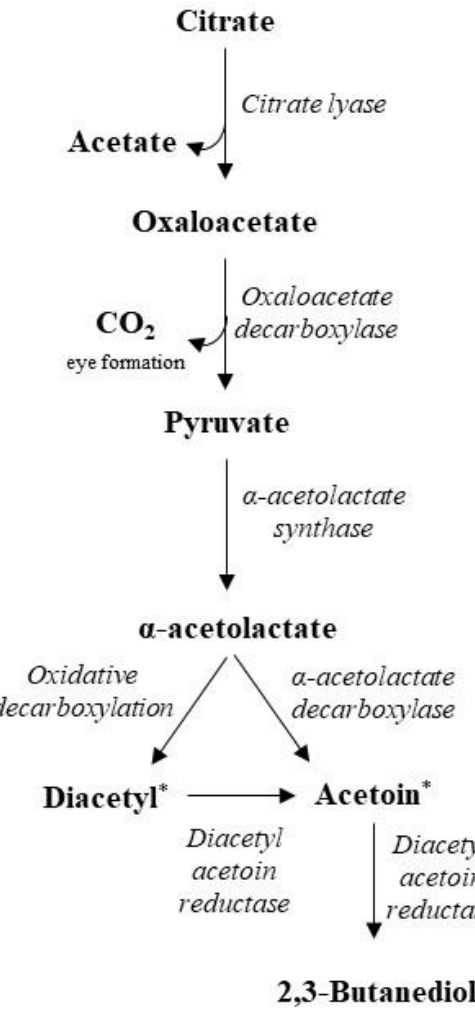
Figure 3. Schematic overview of citrate catabolism by LAB leading to the formation of flavor compounds in cheese. Asterisks denote flavor compounds [6,103,104].